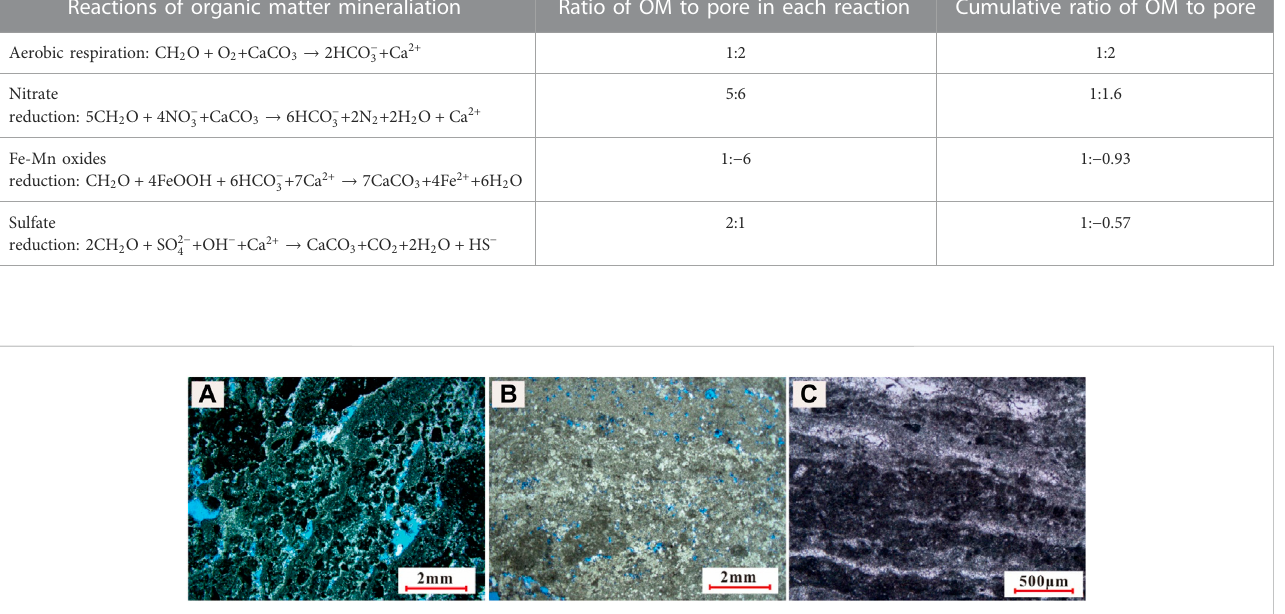
TABLE 3 Reactions of organic matter mineralization and pore development. Reactions of organic matter mineraliation Ratio of OM to pore in each reaction Cumulative ratio of OM to pore